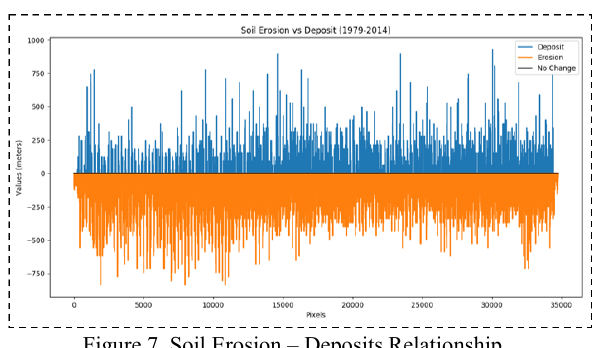
Figure 7. Soil Erosion – Deposits